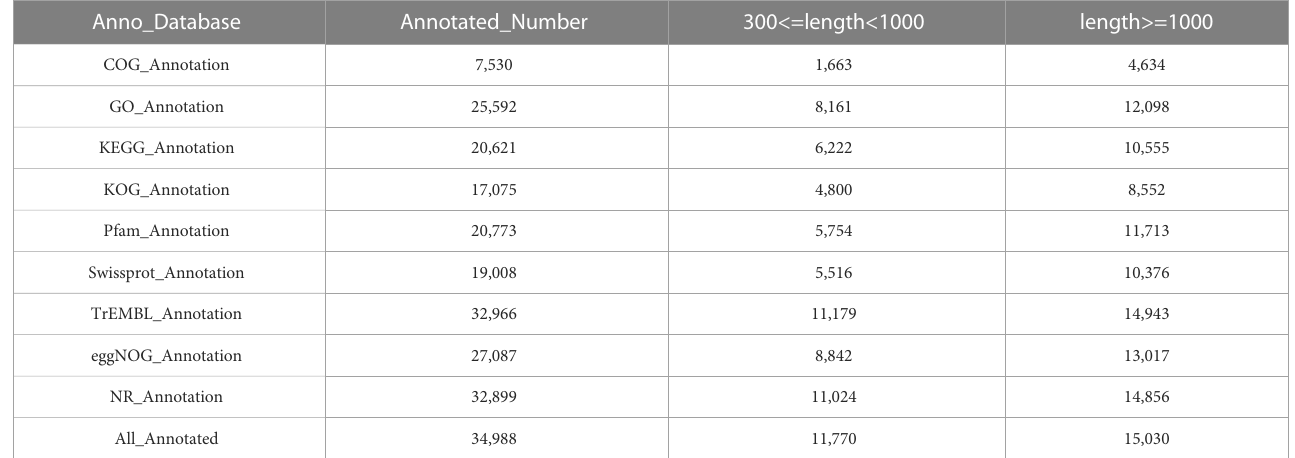
TABLE 6 Numbers of annotated differentially expressed genes